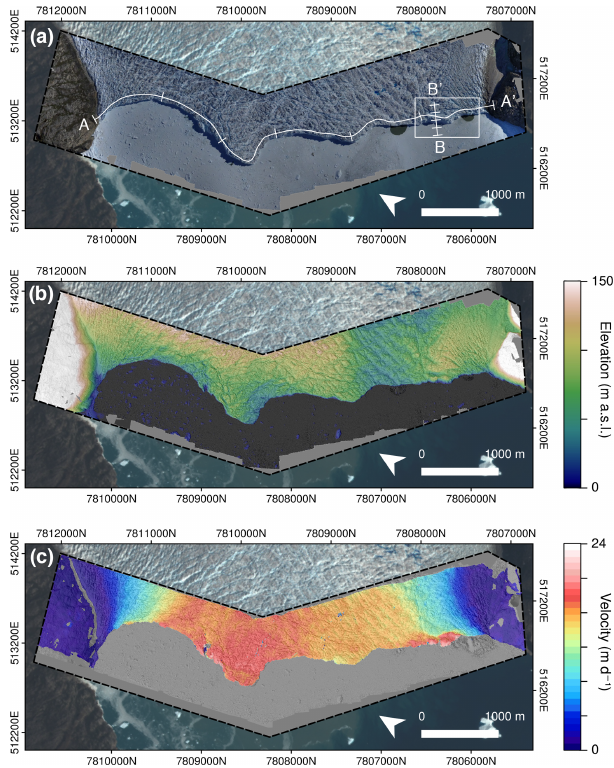
Figure 3. Example data output from calving front. (a) A 0.15m orthophoto, collected at 10:15WGST on 12 July 2017. (b) A 0.2m DEM from the same flight. (c) A 6h separation velocity field ( σ v = ± 0 . 69m) from 16:15 to 22:15WGST on 12 July. The transects in panel (a) refer to Fig. 4. The box refers to the location of Fig.